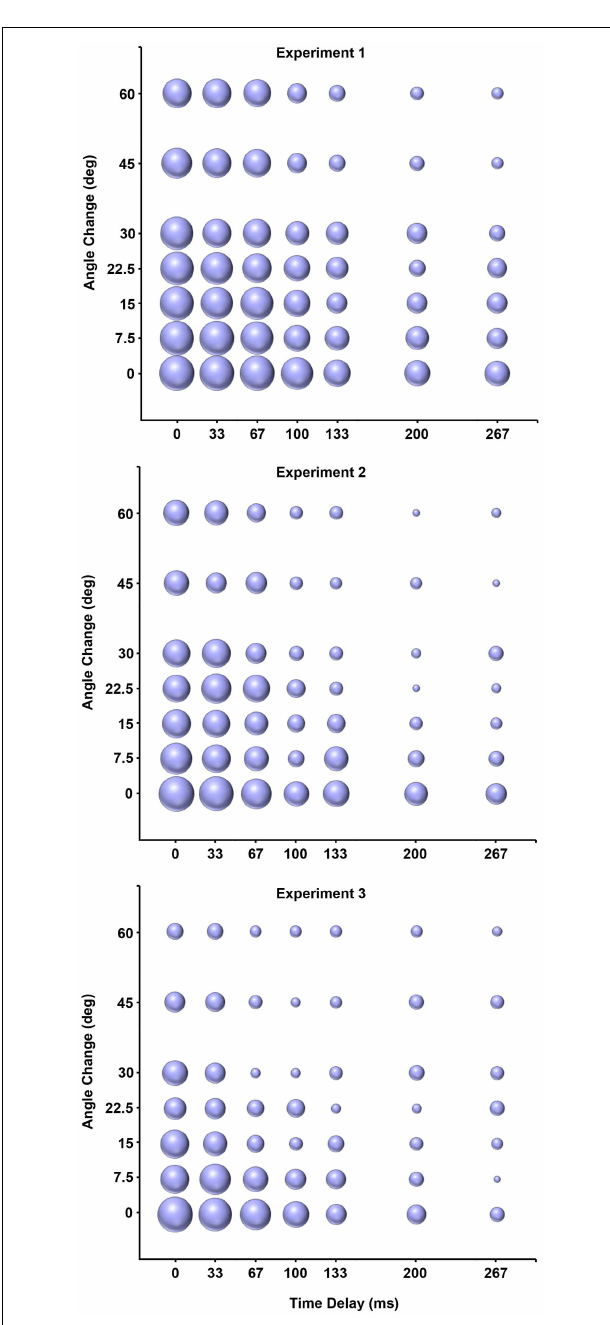
FIGURE 2 | Change in the percent of temporal and spatial parameter combinations judged causal across experiments (Top: Experiment 1, Middle: Experiment 2; Bottom: Experiment 3). Bubble area represents the percentage of a unique parameter combination (e.g., 33ms delay × 15˚ angle change) judged causal. Increased bubble sizes for shorter delays and smaller angle changes, relative to longer delays, and angle changes, demonstrates that participants were more likely to judge shorter delays and angles as causal. Decreased size of bubbles across experiments demonstrates the effects of increased exposure to direct causal launches across experiments. Means for direct launches were calculated based on different numbers of trials in each experiment (Experiment 1 = 2; Experiment 2 = 32; Experiment 3 = 288